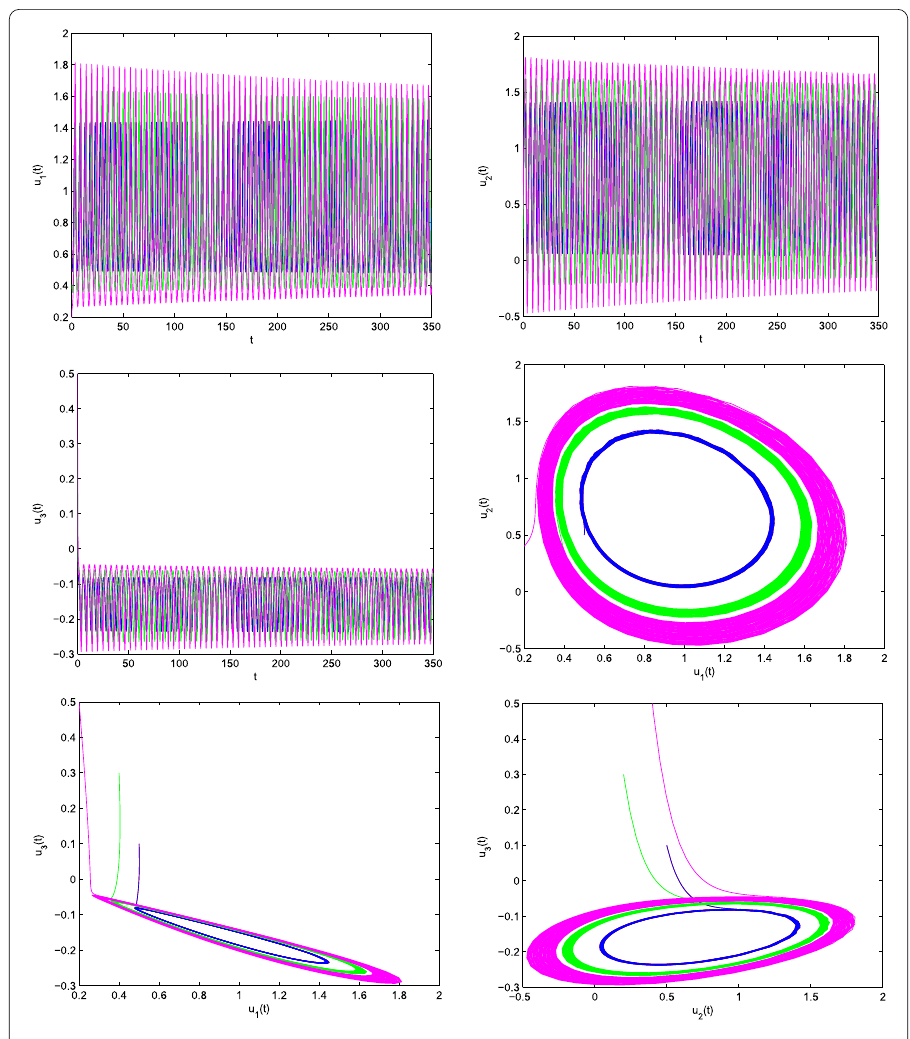
Figure 2 Dynamics of (4.1) with ς = 0.11 > ς 0 ≈ 0.1 and the initial value